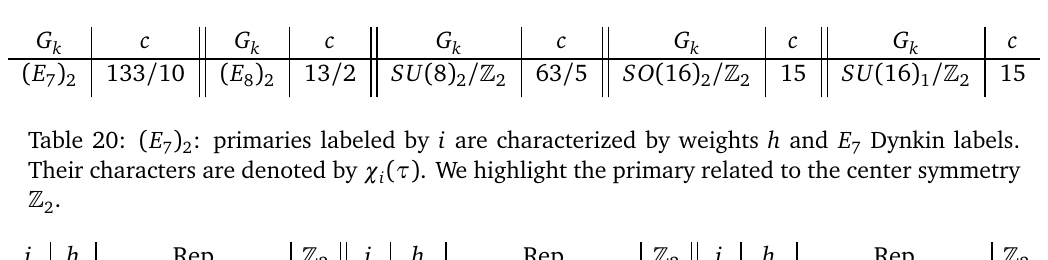
Table 19: Five WZW models related to spontaneously broken supersymemtric RCFTs.